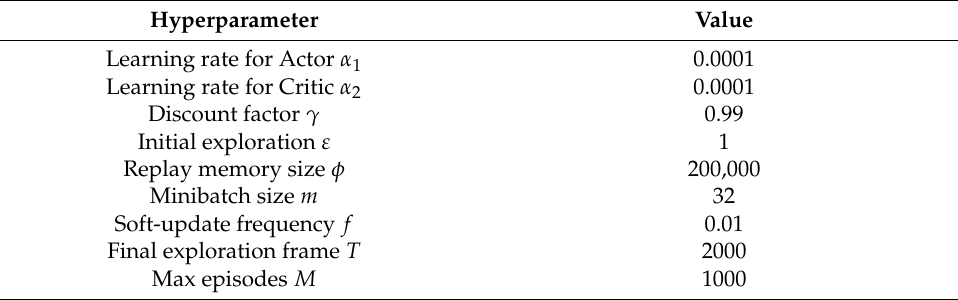
Table 6. DDPG or SumTree-DDPG’s per parameter in environment 2.